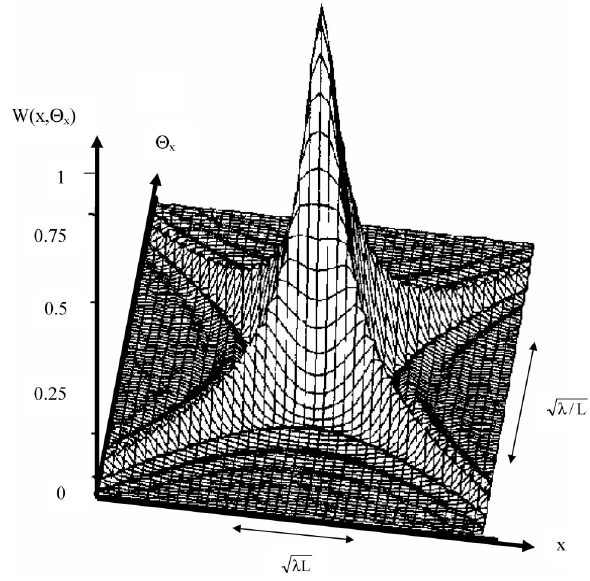
FIG. 2. The Wigner distribution function of undulator- synchrotron radiation in 2D space-angle ( X; (cid:21) [21].